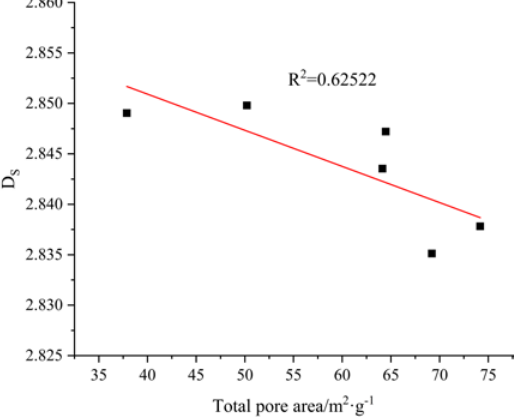
Figure 14. Relationship between fractal dimension and total pore area.